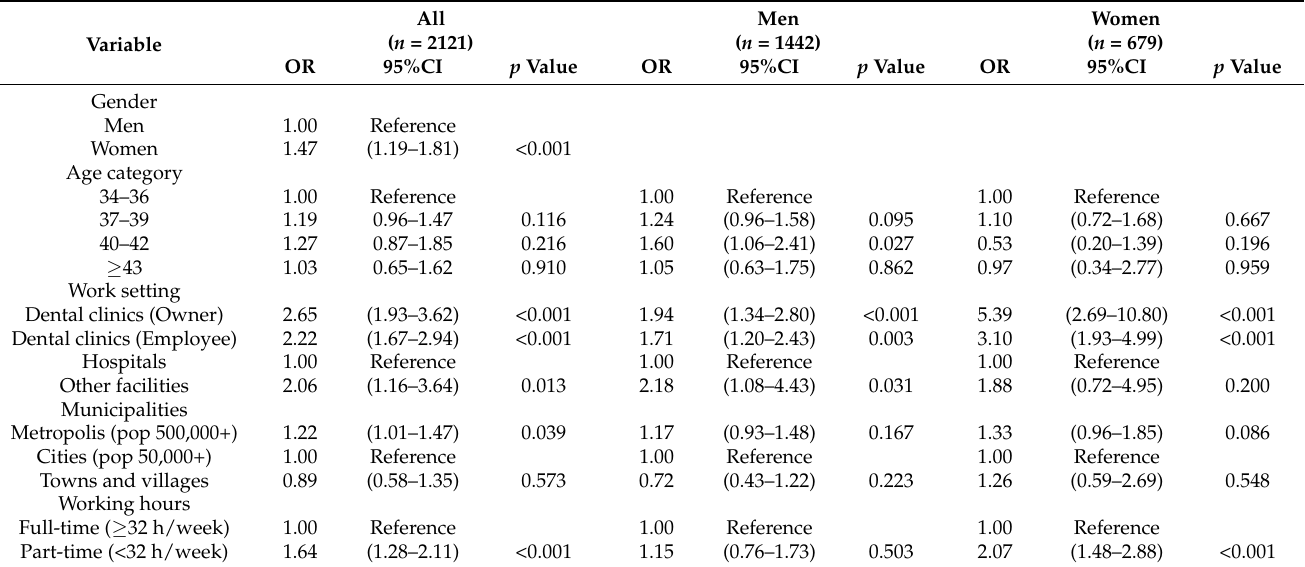
Table 3. Odds ratio for the “returned to practice” group at 10 years after registration as